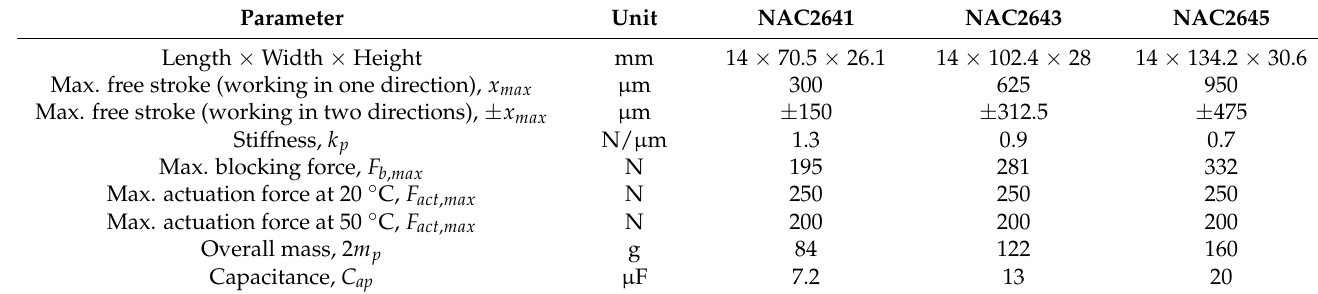
Table 1. Amplified stack actuators produced by Noliac: specifications